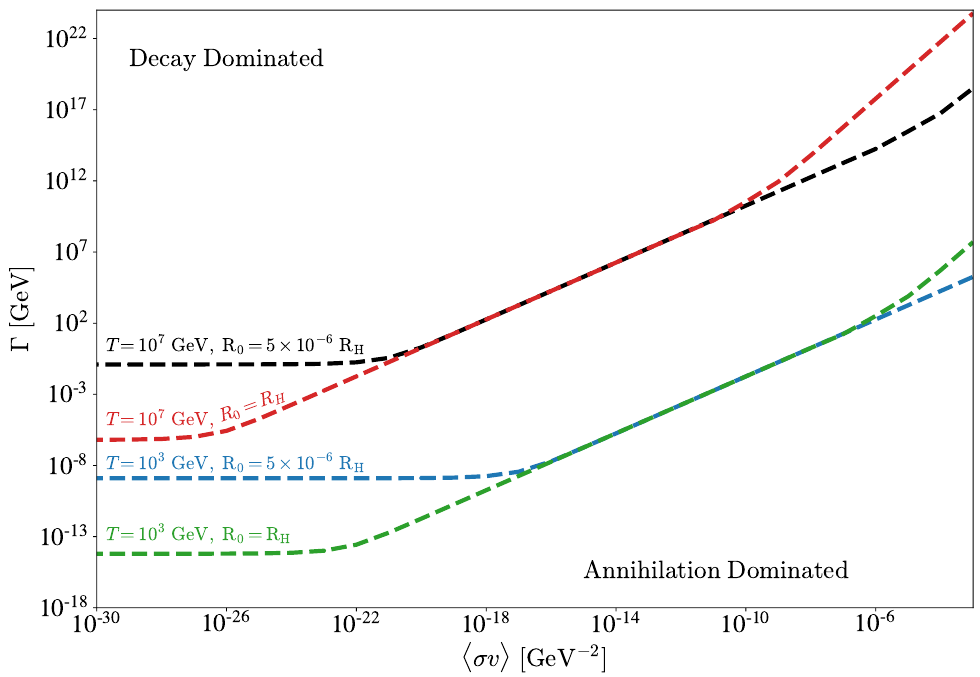
Figure 3 . Contours in the Γ – h σv i plane corresponding to the points where χ is depleted by an equal number of decays and annihilations during the pocket collapse. The four curves correspond to combinations of temperature T = 10 7 GeV and initial radius R 0 = 5 × 10 − 6 R H (black); T = 10 7 GeV and R 0 = R H (red); T = 10 3 GeV and R 0 = 5 × 10 − 6 R H (blue); and T = 10 3 GeV and R 0 = R H